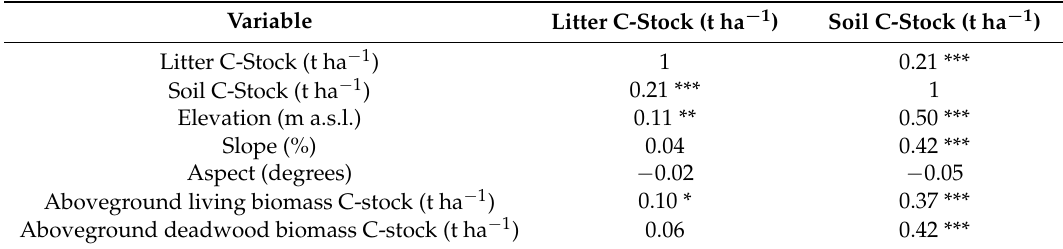
Table 6. Stepwise multiple regression results for litter C ‐ stock and soil C ‐ stock.